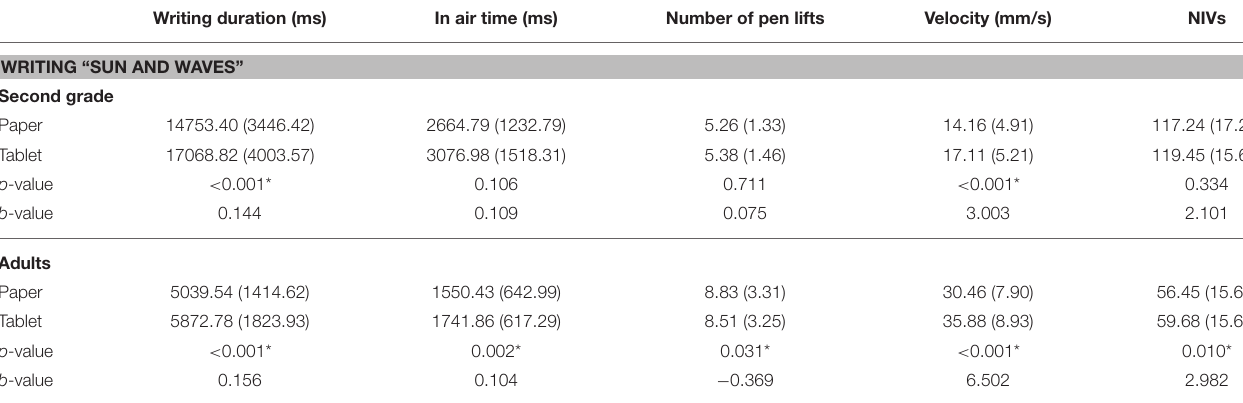
TABLE 4 | Means and standard deviations in parentheses for writing measures of writing the phrase “sun and waves.”